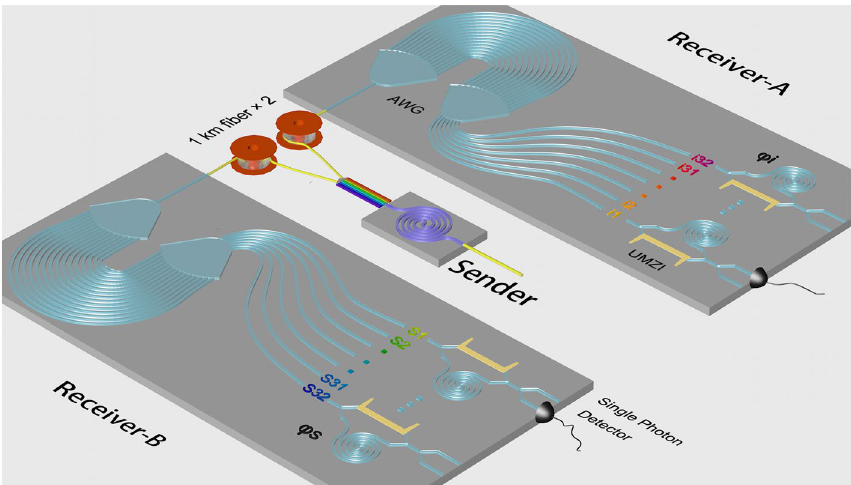
Fig. 1 Schematic diagram of multi‑chip interconnection for energy‑time entanglement distribution. The silicon‑on‑insulator chip is the sender and generates correlated wideband photon pairs via the spontaneous four‑wave mixing process. The photons are divided and sent to two receivers of the quantum network. At the receiver terminal, photons are subdivided into different wavelength channels by the AWG. Entanglement preparation and analysis are carried out by the on‑chip UMZIs. The energy‑time entangled photons are detected by single photon detectors. AWG: arrayed waveguide grating; UMZI: unbalanced Mach‑Zander